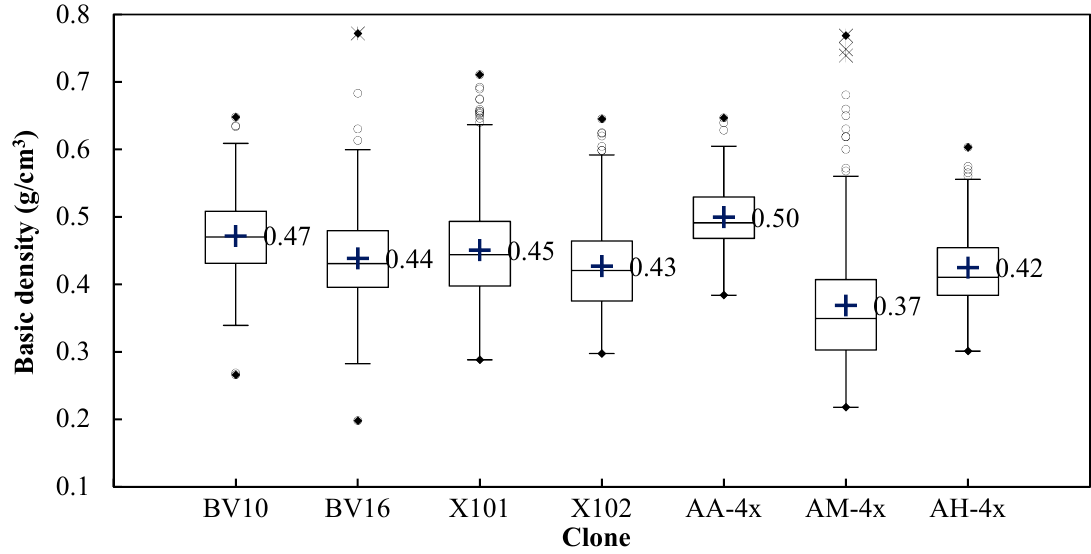
Figure 4. Variation of basic density (g/cm 3 ). Table 2. Wood properties and ANOVA results in different clones.